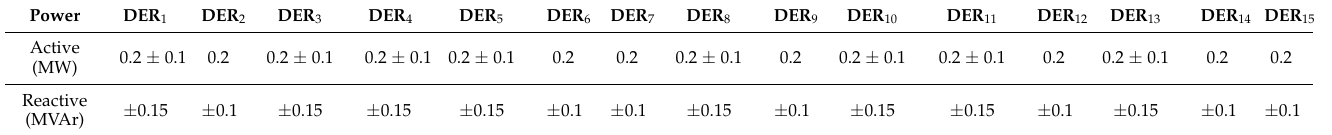
Table 1. Allowable range of the active and reactive powers injected/absorbed by